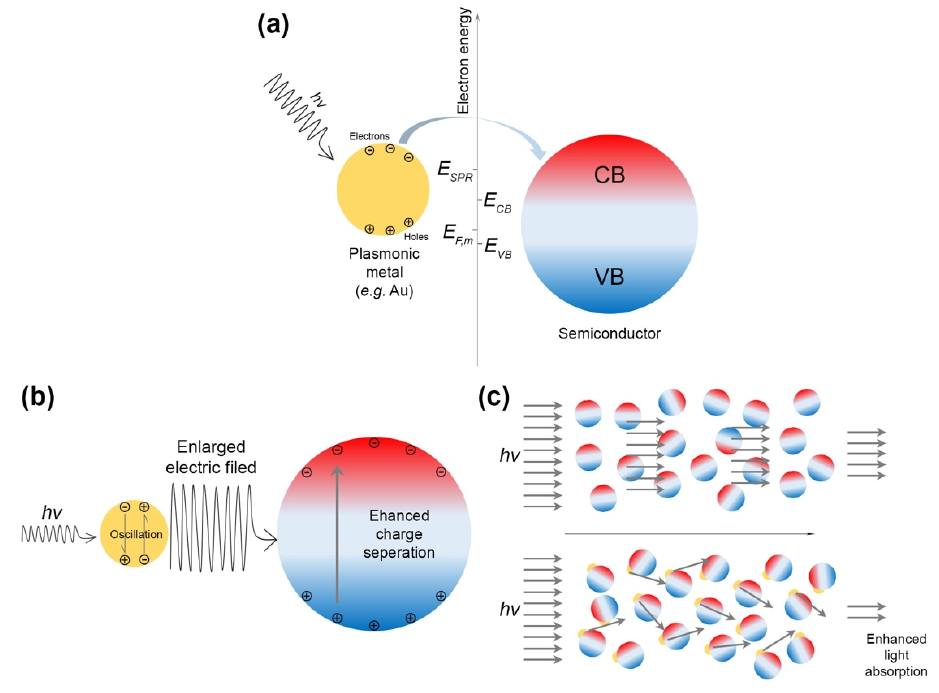
Figure 3. ( a ) SPR-induced electron injection; ( b ) Charge separation induced by NFEF; ( c ) Scattering-enhanced light absorption.